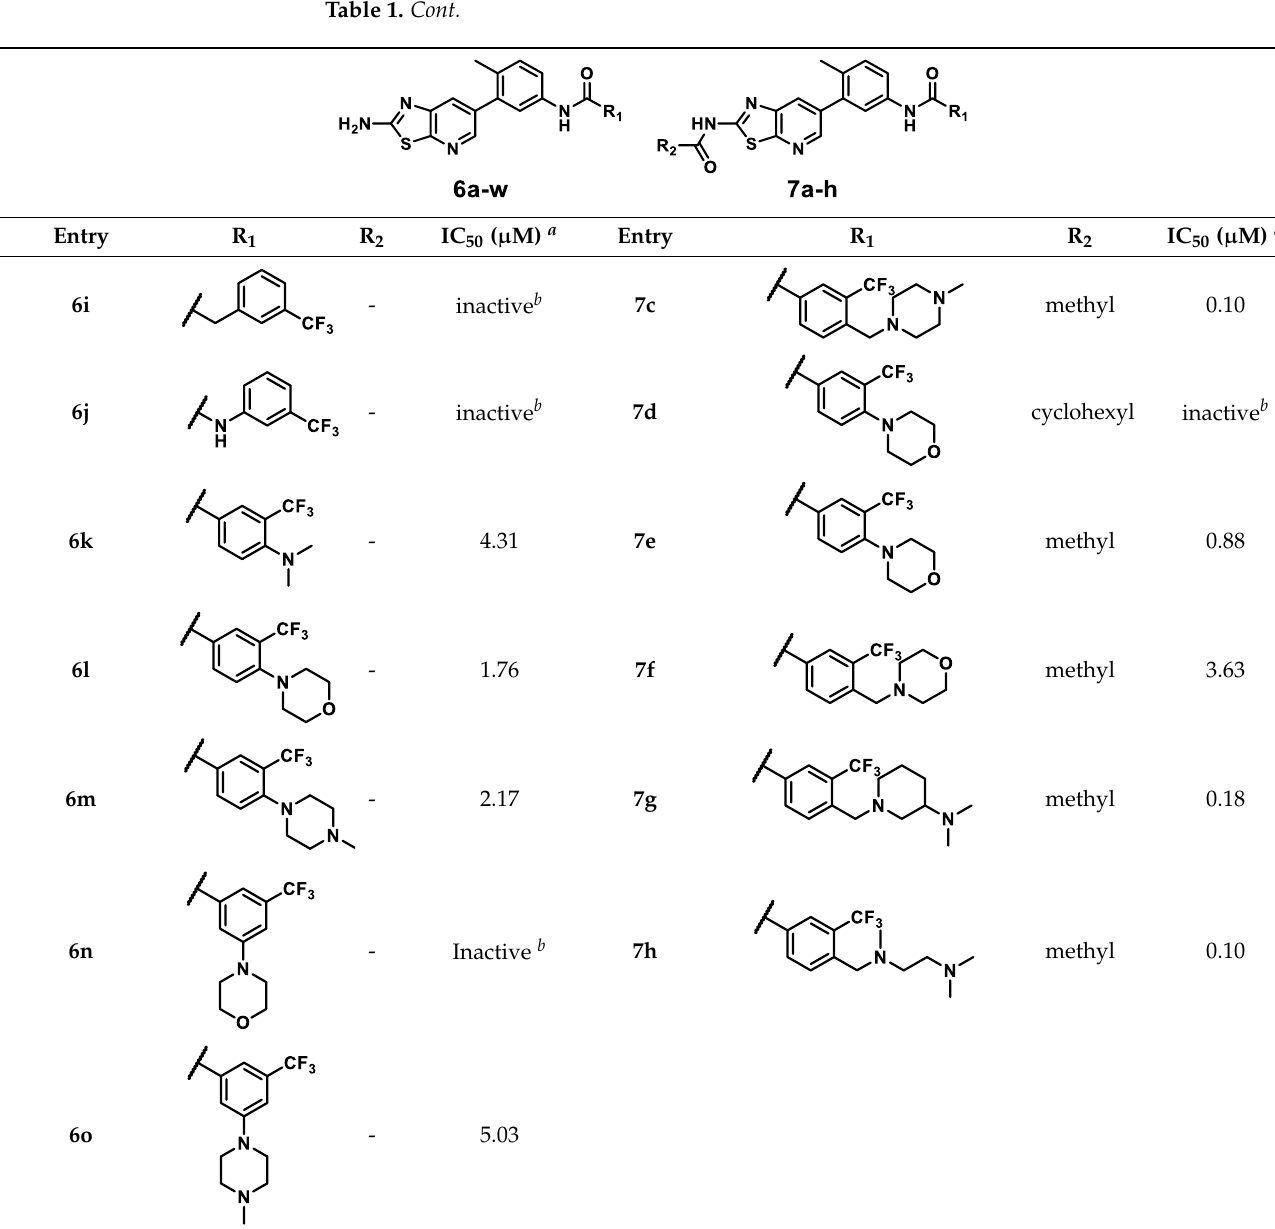
Table 2. Anti-proliferative activities of thiazolo[5,4- b ]pyridine derivatives 6a – w and 7a – h against GIST-T1 and HMC1.2 cells.